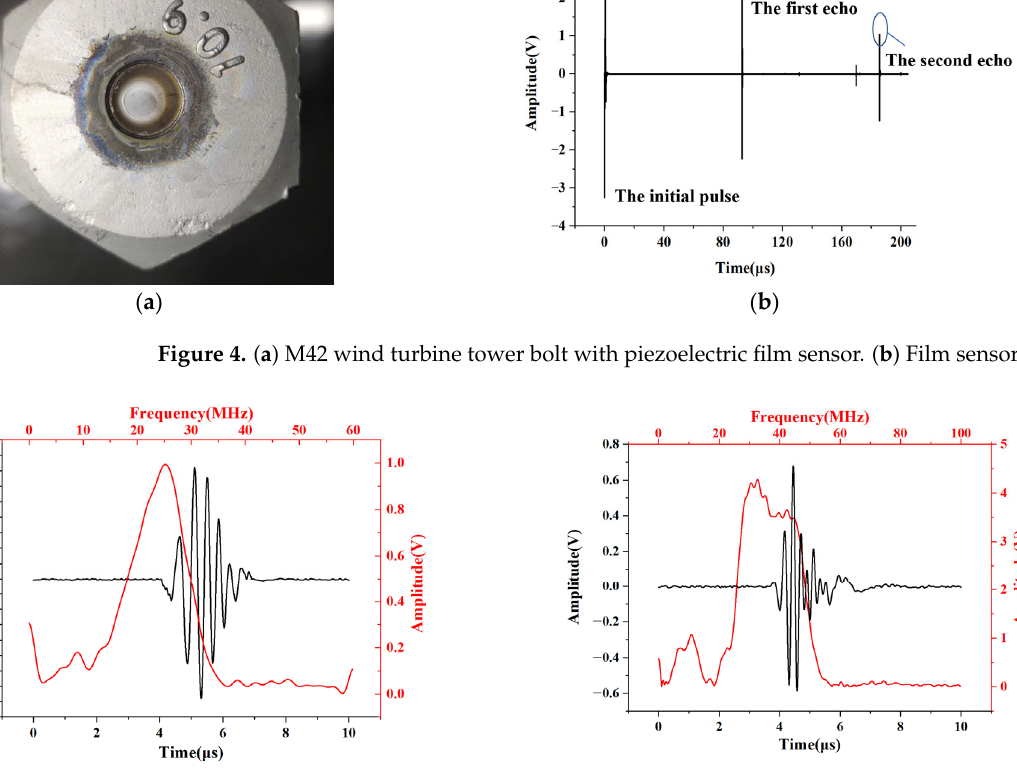
Figure 4. ( a ) M42 wind turbine tower bolt with piezoelectric film sensor. ( b ) Film sensor echo signal.